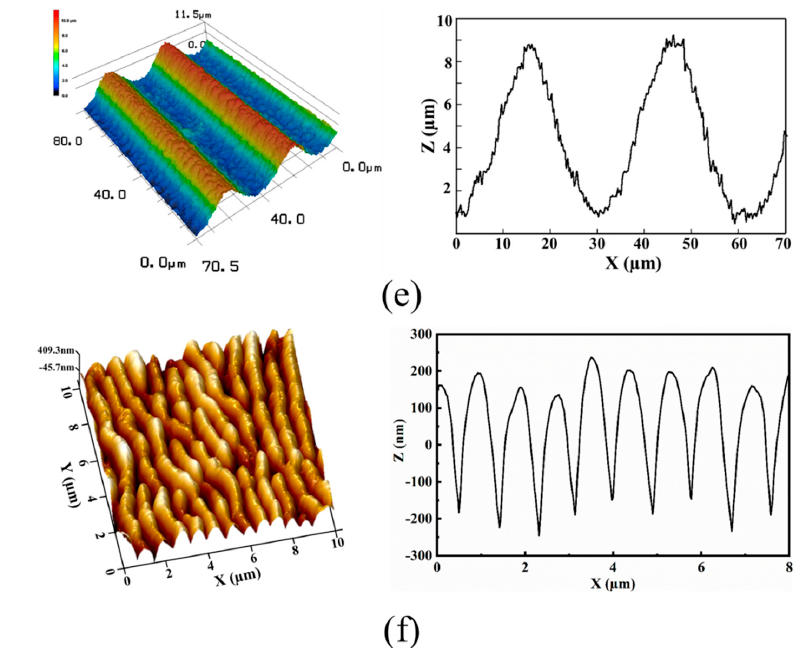
Figure 2. Micrograph of hierarchical laser induced periodical surface structures (LIPSS): ( a ) 45° view of scanning electron microscope (SEM) image; ( b ) magnification of nano-particles; ( c ) magnification of LIPSS; ( d ) the size distributions of nanoparticles; ( e ) 3D surface topography (left), height profiles of hierarchical LIPSS (right); ( f ) Atomic force microscopy image of the LIPSS; height profiles of nano-ripples (right).